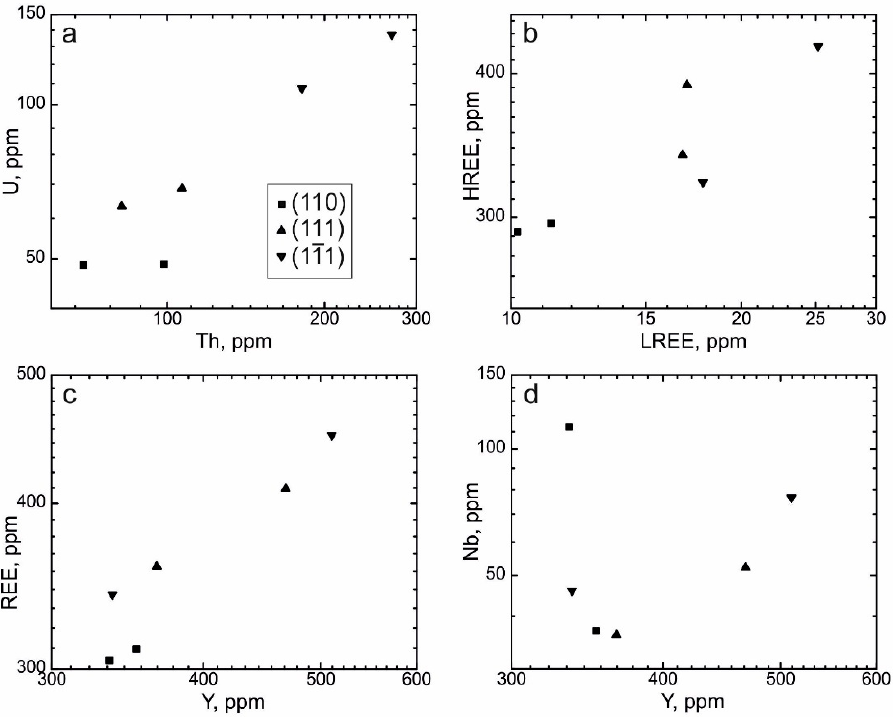
Figure 6. ( a ) Th versus U; ( b ) LREE versus HREE; ( c ) Y versus REE; ( d ) Y versus Nb in the first growth zone of zircon (points 6, 14, 22, 29, 41, и 50).